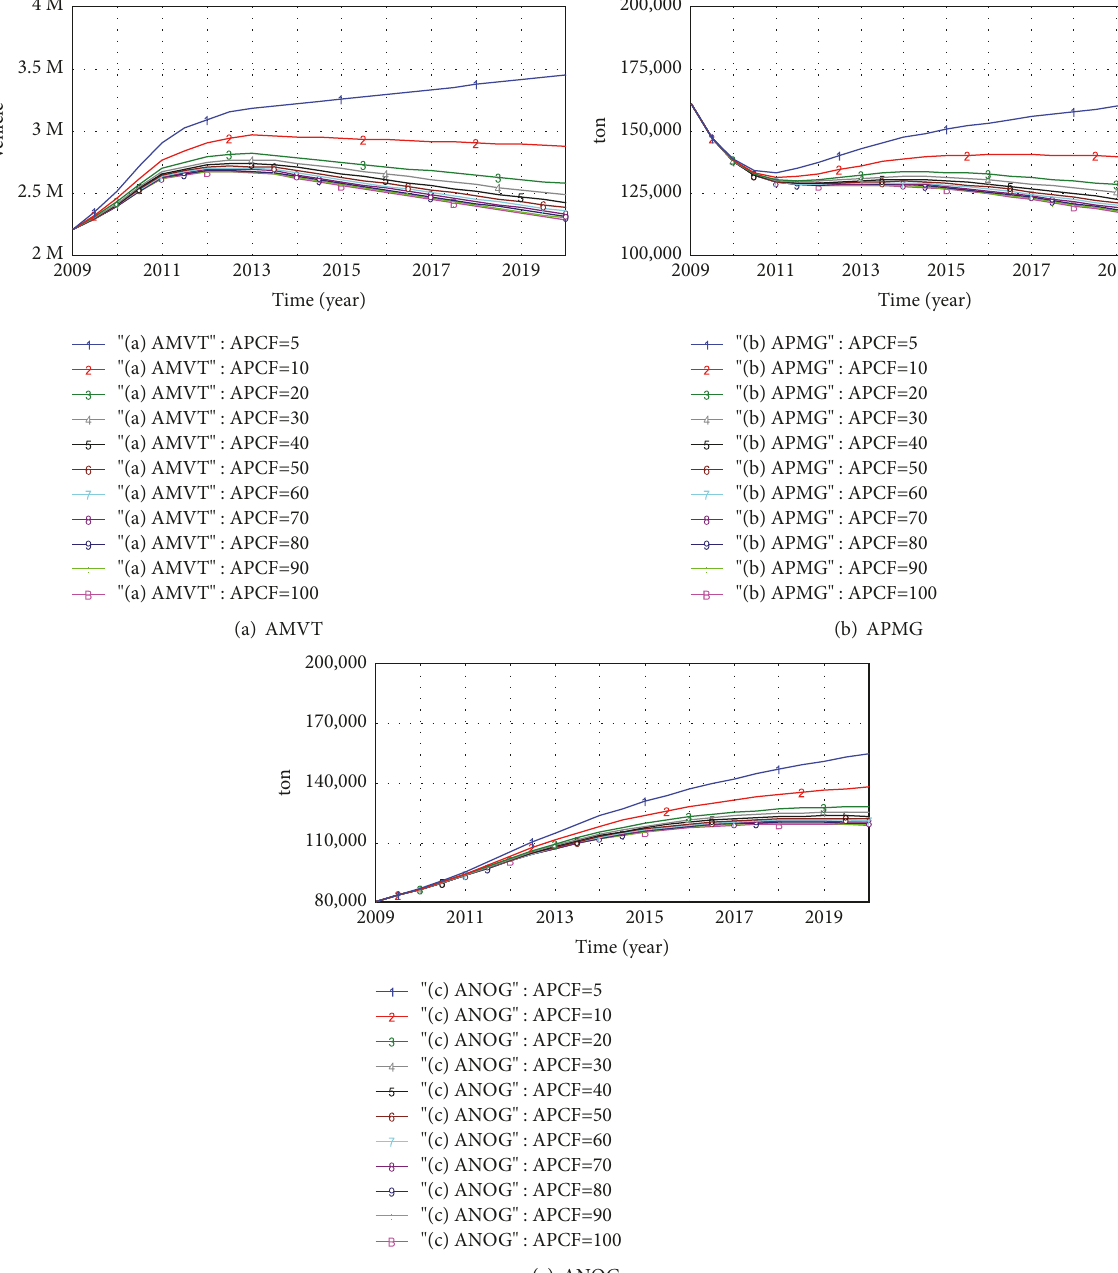
Figure 4: Sensitivity test. (a) AMVT. (b) APMG. (c)